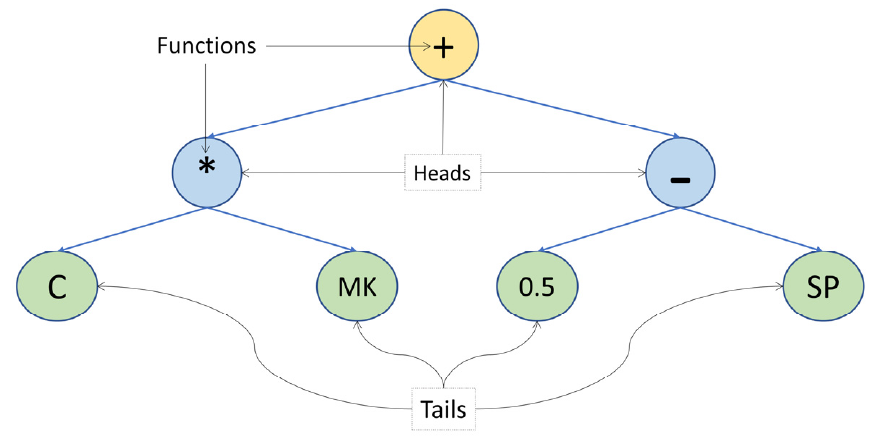
Figure 1. ET with one gene and three head size.